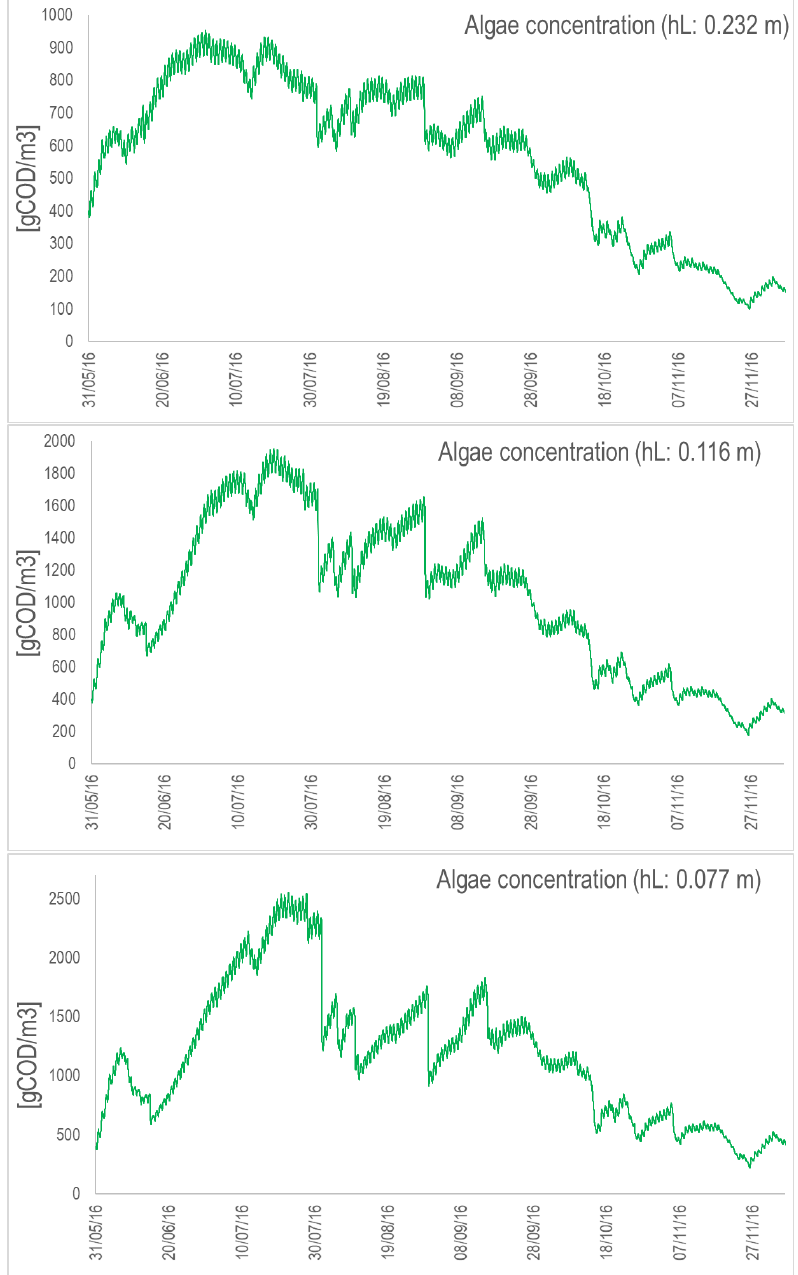
Figure A7. Algal concentration (in COD/m 3 ) for the concrete raceway with the nominal depth ( top ), depth divided by 2 ( middle ), and depth divided by 3 ( bottom ). Simulations are from May to November